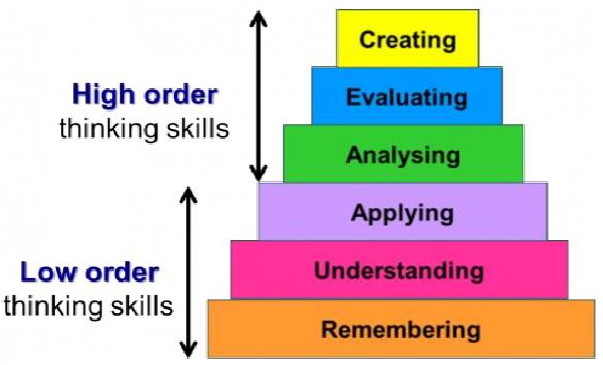
Figure 1. Bloom’s revised tax onomy and HOTS.